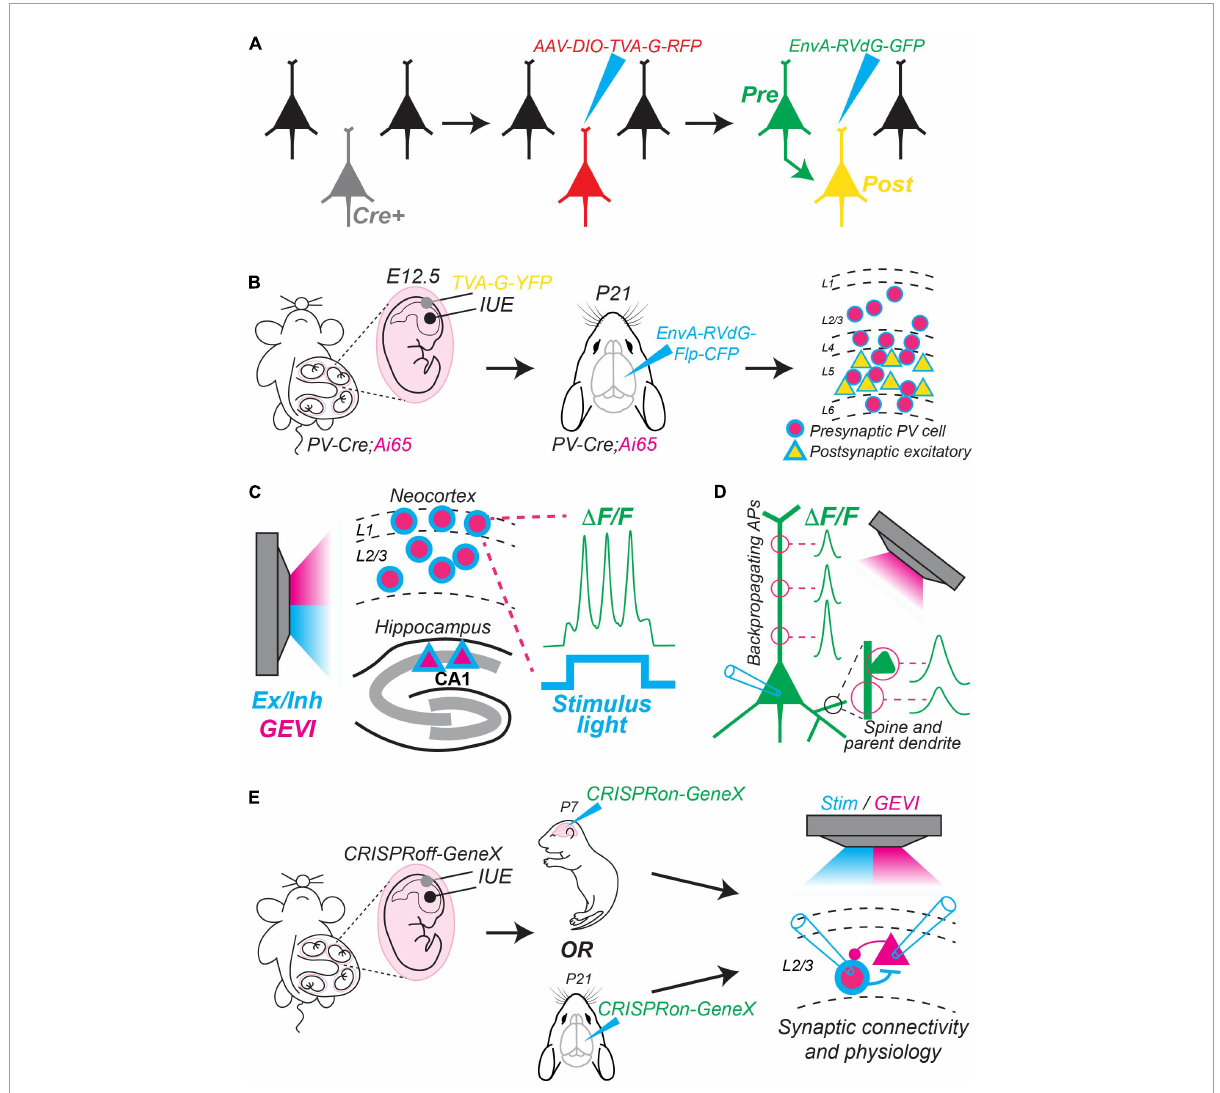
FIGURE2 New methods to map and manipulate circuit motifs. (A) Conventional method of monosynaptic retrograde rabies tracing. First, an appropriate Cre driver mouse line is chosen. Second, an AAV (helper virus) is injected that encodes a Cre-dependent construct containing TVA, G, and red fluorescent protein (RFP). Finally, pseudotyped g-deleted rabies (EnvA-RVdG) encoding green fluorescent protein (GFP) is injected. Only Cre-expressing cells previously infected with the AAV express TVA, which allows them to be further infected by EnvA-RVdG. Thus, they express red and green fluorophores (yellow). The yellow cells also express the missing G, which allows EnvA-RVdG to travel retrograde to label presynaptic cells in green. Green cells lack G, so spread of the rabies virus stops. (B) Summary of experimental steps used by Yetman et al. (2019) to map connections between excitatory and inhibitory neurons using a Cre/Flp intersectional approach combined with monosynaptic rabies tracing. In this example, PV+ interneurons that are presynaptic to deep layer excitatory pyramidal cells are mapped. They used a PV-Cre mouse crossed to an Ai65 dual Cre/Flp conditional reporter line encoding RFP. First, they performed in utero electroporation (IUE) at embryonic day 12.5 (E12.5) to deliver a plasmid encoding TVA, G, and yellow fluorescent protein (YFP) to progenitors of deep layer neocortical projection neurons. Second, they injected EnvA-RVdG encoding Flp and cyan fluorescent protein (CFP) at postnatal day 21 (P21). This results in deep layer excitatory starter neurons that express both cyan fluorescent protein (CFP) and yellow fluorescent protein (YFP); presynaptic PV+ interneurons express both RFP and CFP. (C) Different neuronal subtypes (e.g., neocortical interneurons or hippocampal CA1 pyramidal cells) can be made to simultaneously express a genetically encoded voltage indicator (GEVI) (pink) and a blue-shifted optogenetic activator or inhibitor for